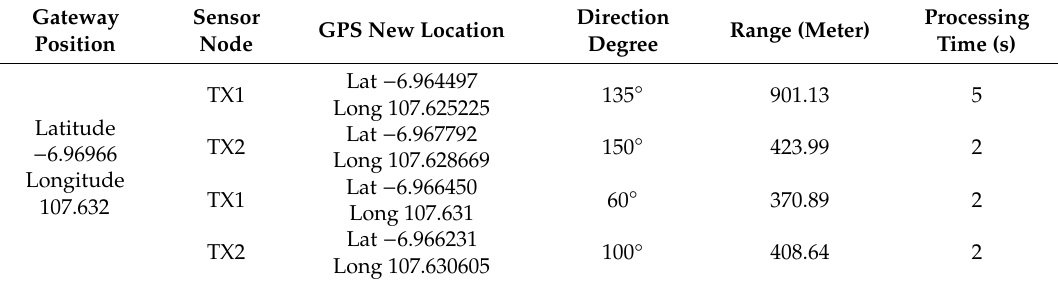
Table 2. Test Result Tracking of Proposed System at LoS Location.